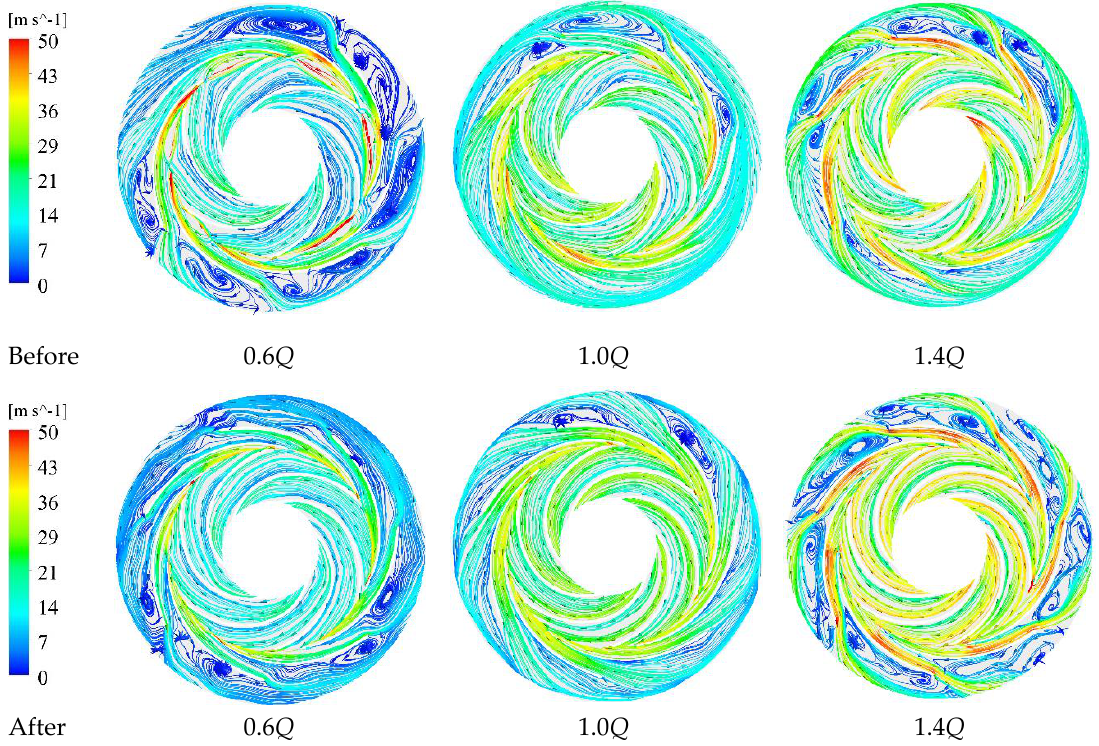
Figure 19. Streamline distribution of the secondary impeller-guide vane.